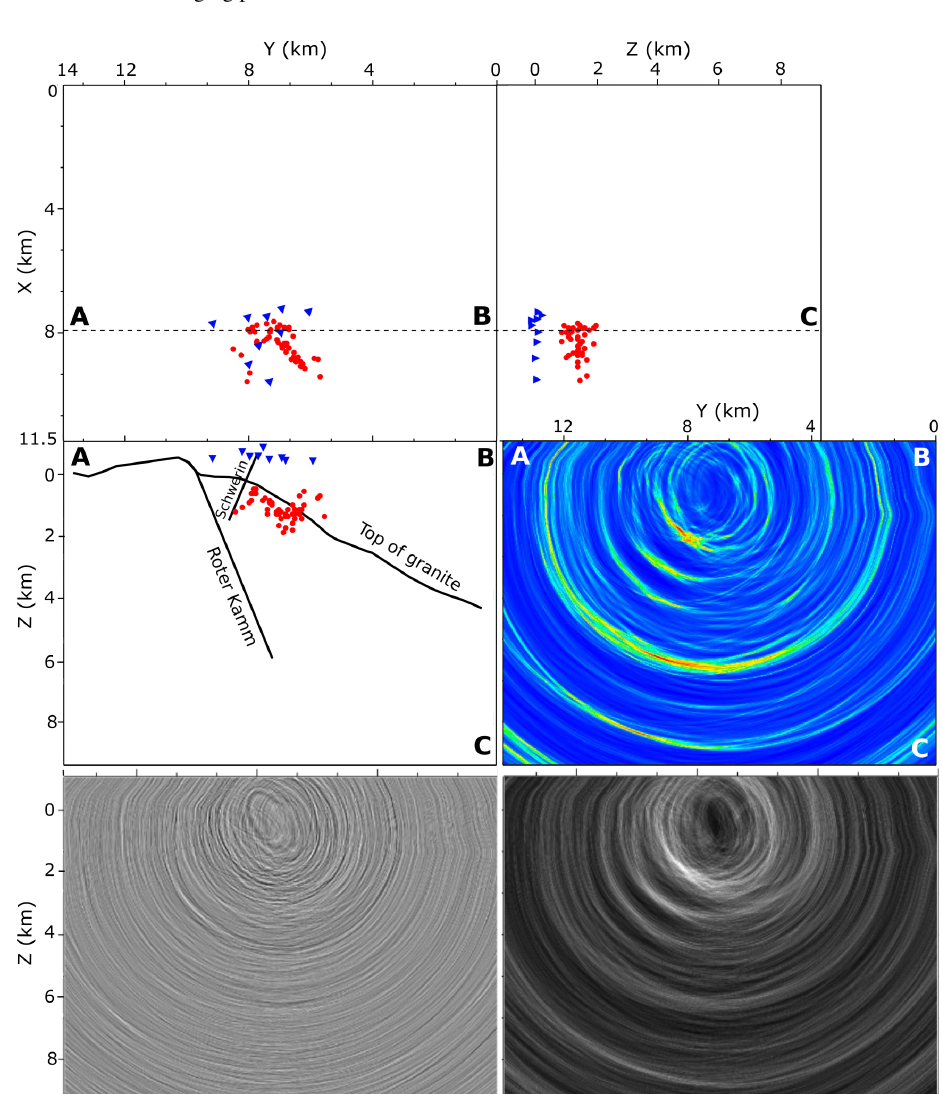
Figure 7. Top and side views of the 3D model and the position of sources (red dots) and receivers (blue triangles) that contributed in the migration procedure and the major geological structures (top and middle left). A slice through the coherency image (middle right), the phase- consistent image (bottom left), and the absolute values image (bottom right). The dashed line ABC refers to the position of the shown image